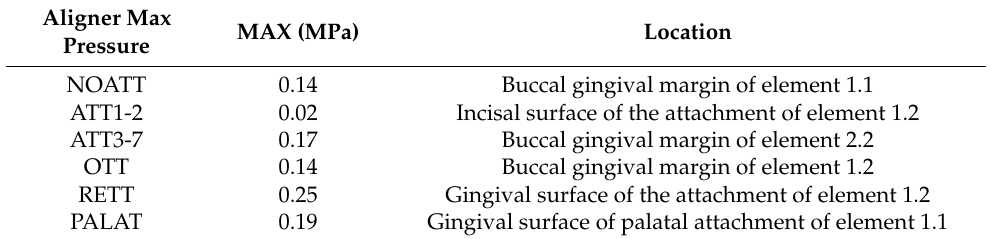
Table 2. Aligner maximum pressure locations.